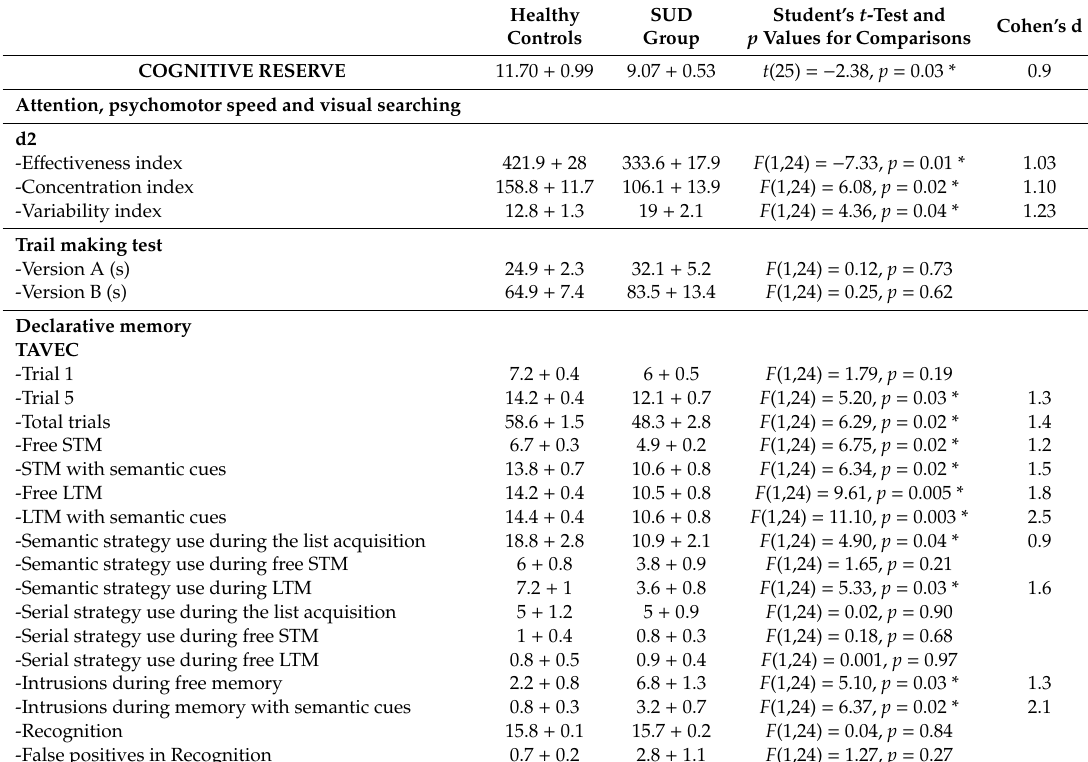
Table 2. Neuropsychological tests